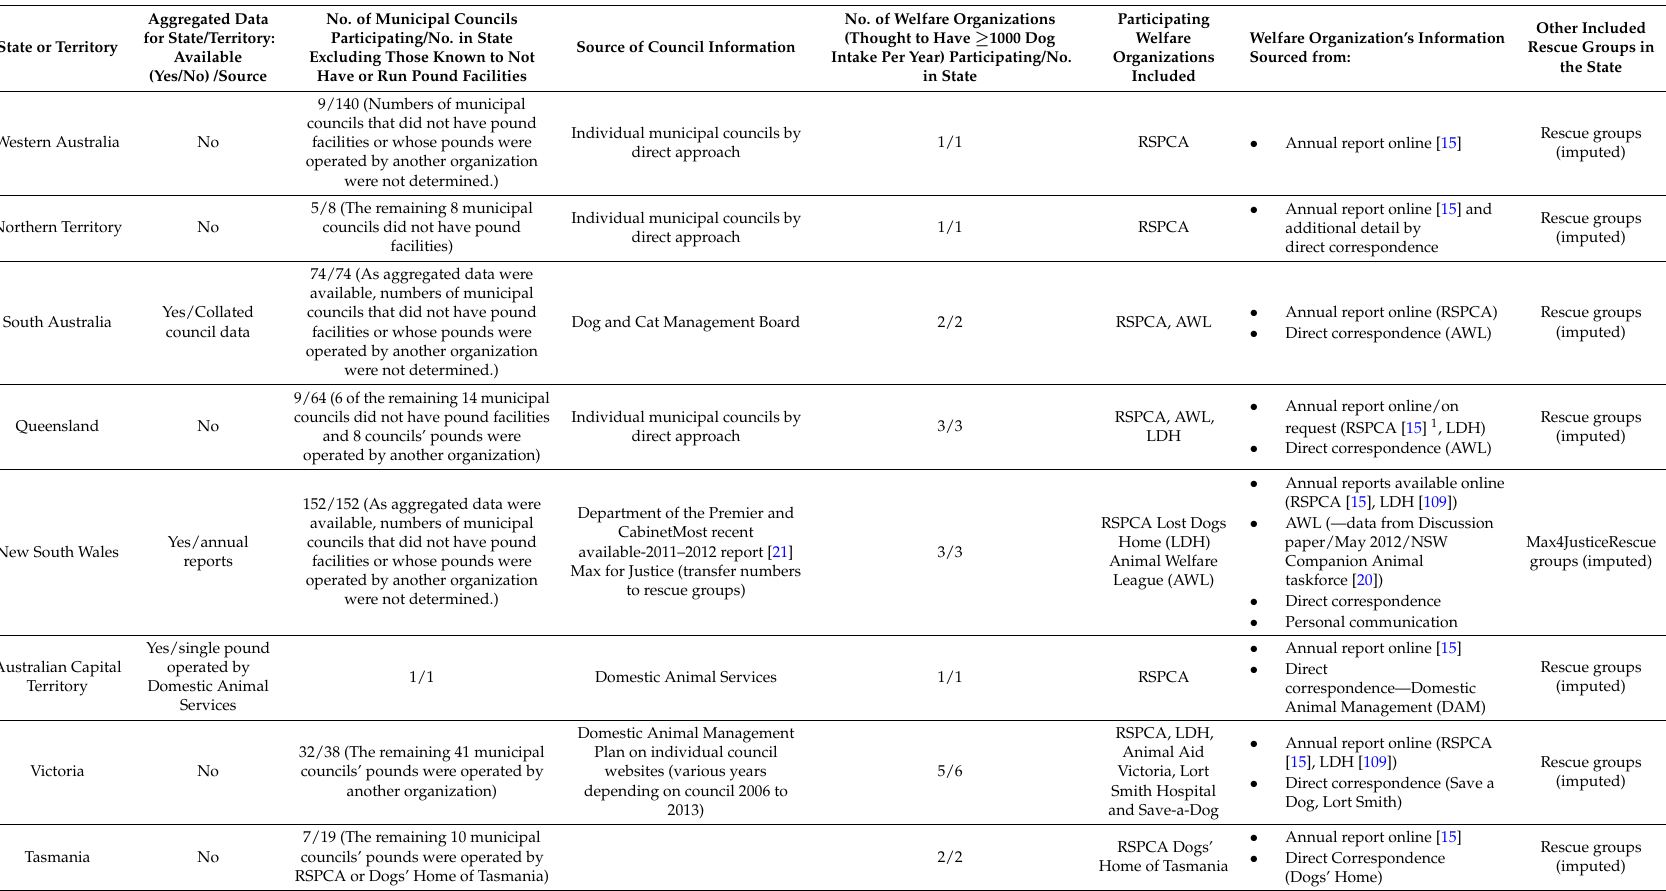
Table A1. Sources of data by state and territory (for 2012–2013 unless otherwise